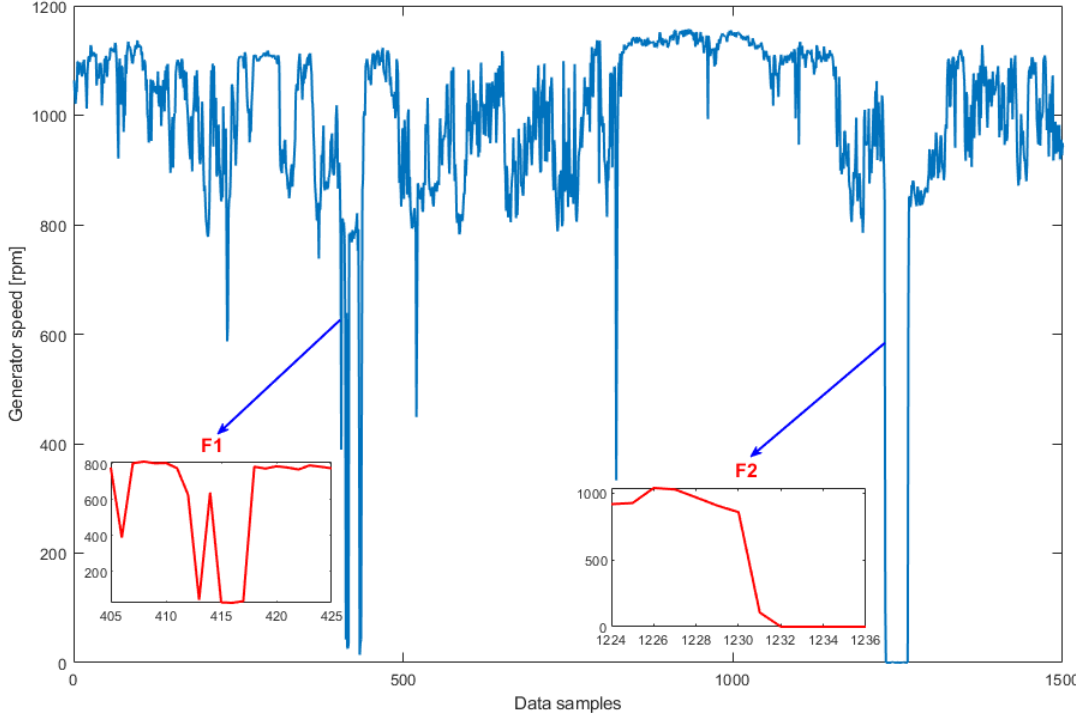
Figure 7. Generator speed data displaying the abnormal operating state (F1) and the gearbox fault (F2) occurred during monitoring process.